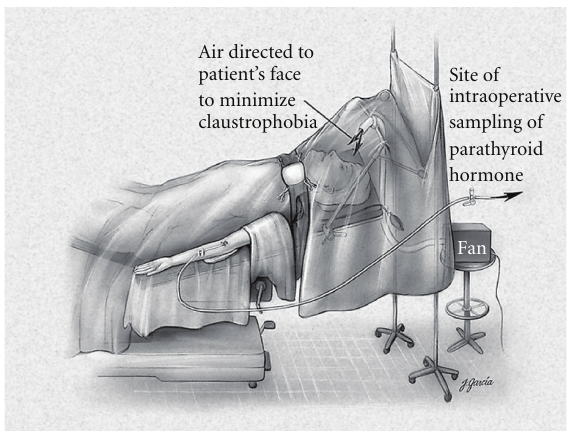
Figure 3: The patient has a large-bore peripheral intravenous line inserted, which is used for medication and fluid administration, as well as sampling for parathyroid hormone (PTH) levels. The patient is awake, and a fan is used to blow room air gently toward his or her face to minimize the sensation of claustrophobia. (From [36], with permission, Copyright 2002, Lippincott Williams &